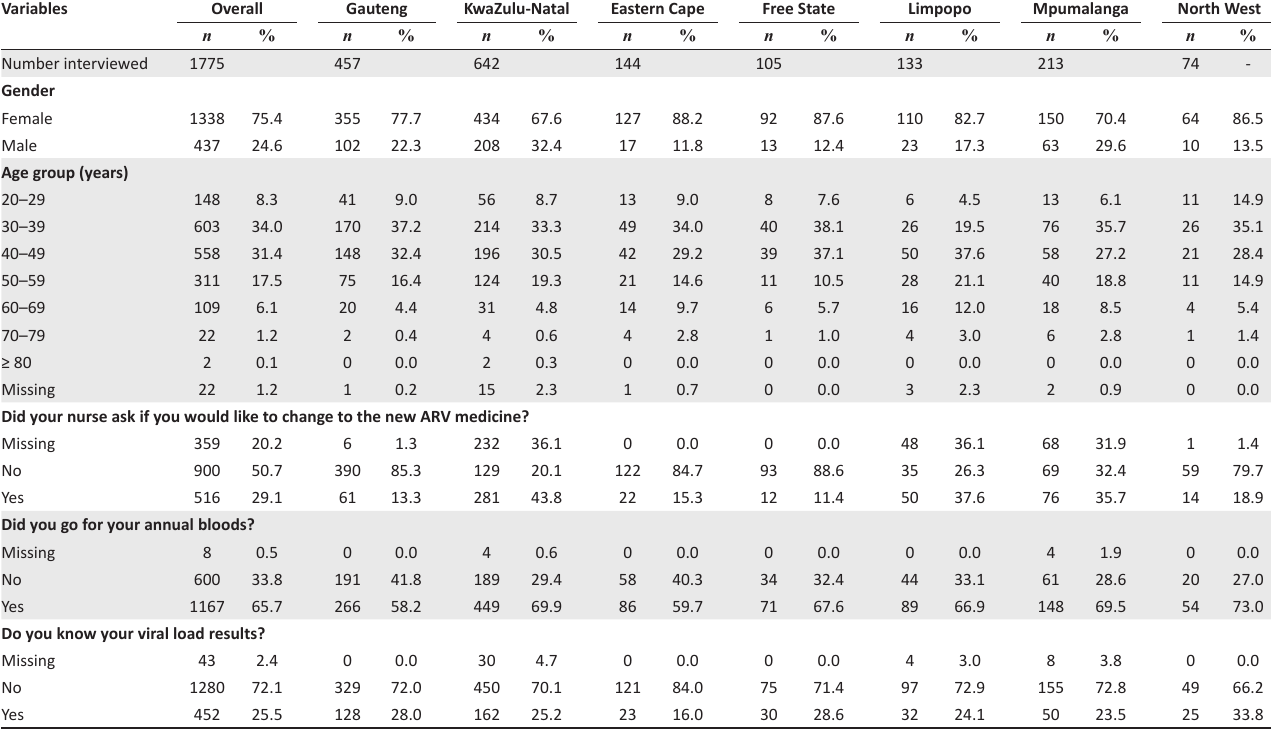
TABLE 4: Participant characteristics of patients on the tenofovir disoproxil fumarate/emtricitabine/efavirenz regimen.